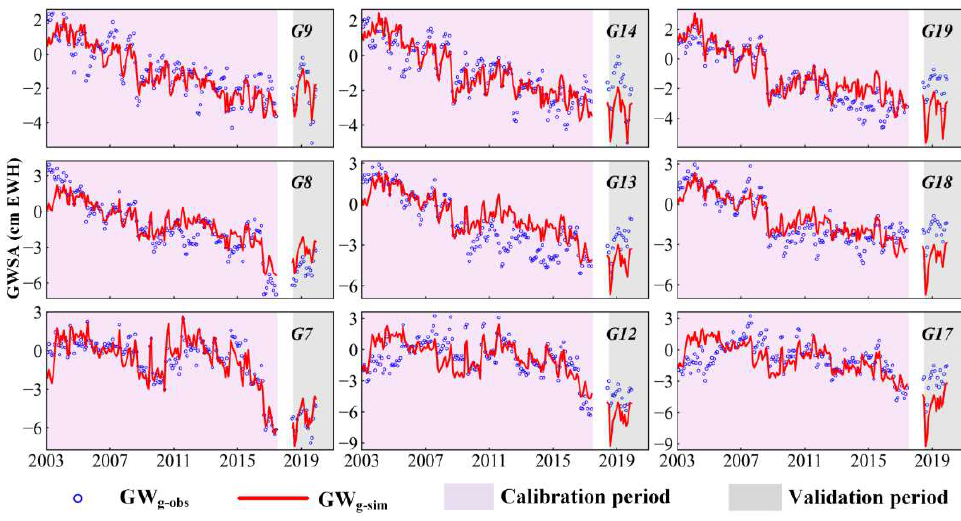
Table 2. Coefficient and RMSE for each cell in the calibration and validation periods.